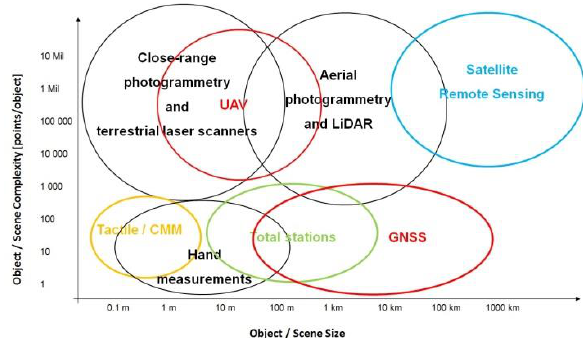
Figure 2: Available (3D) recording technologies (after Boehler and Heinz, 1999). According to the working scale and required products, we can summarize the available data and sources (i.e. sensors, platforms, instruments, etc.) as shown in Fig.3 (Lambers and